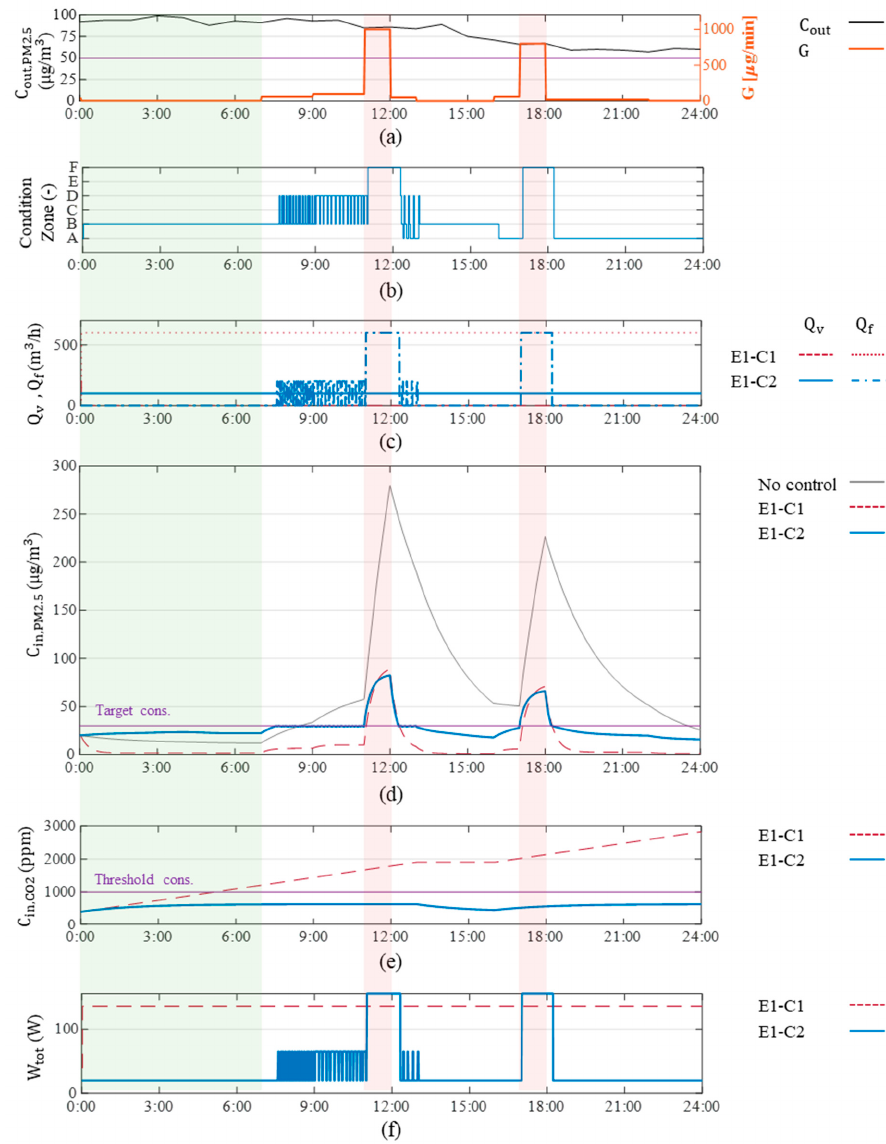
Figure 16. The results of ( a ) indoor and outdoor PM conditions, ( b ) condition zones, ( c ) operation flow rates of the system, ( d ) indoor PM2.5 concentration, ( e ) indoor CO2 concentration, and ( f ) system fan power consumption during E2.